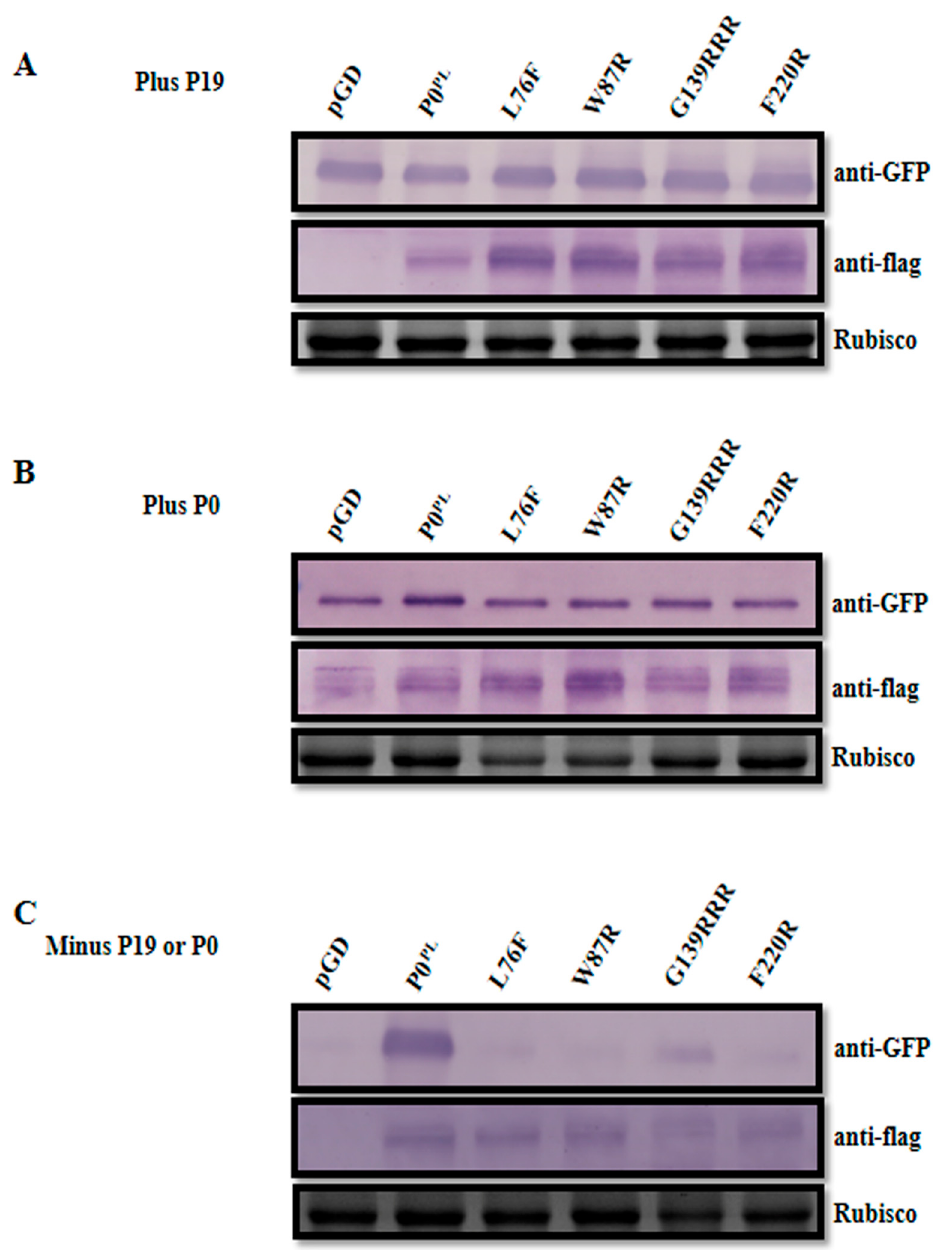
Figure 3. Western blot analysis showing accumulation of GFP and flag-fused P0 PL mutants in N. benthamiana leaves. Proteins were extracted at 3 dpi from the N. benthamiana leaves co-infiltrated with pGDG plus empty pGD vector (negative control), P0 PL (wild-type), and L76F, W87R, and G139RRR mutants respectively, in the presence or absence of the Tomato bushy stunt virus (TBSV) P19 protein or P0 protein of Potato leafroll virus . Rubisco stained with Coomassie brilliant blue was used as a loading control as is shown in the lower panel. ( A ) Plus P19; ( B ) plus P0 PL ; ( C ) minus P19 or P0 PL .